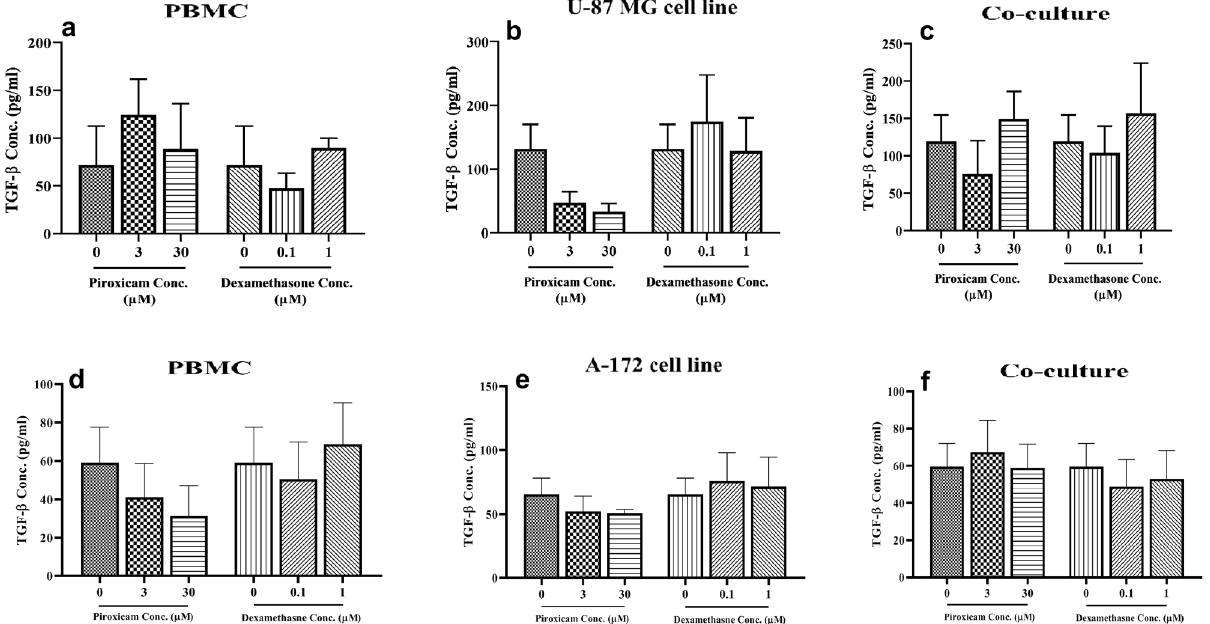
Figure 9. The effect of drugs on the TGF-β levels of T cells in PBMCs alone or in the co-culture condition. The effect of dexamethasone and piroxicam was measured on the TGF-β levels of T cells in PBMCs alone ( a, d ), U-87 MG cell line ( b ), A-172 cells ( e ), and in the co-culture with U-87 MG ( c ) and A-172 cells ( f ) (n = 4). The graphs show the mean ± SD. Significant changes are indicated with asterisk (* p < 0.05, ** p < 0.01, *** p < 0.001, **** p <